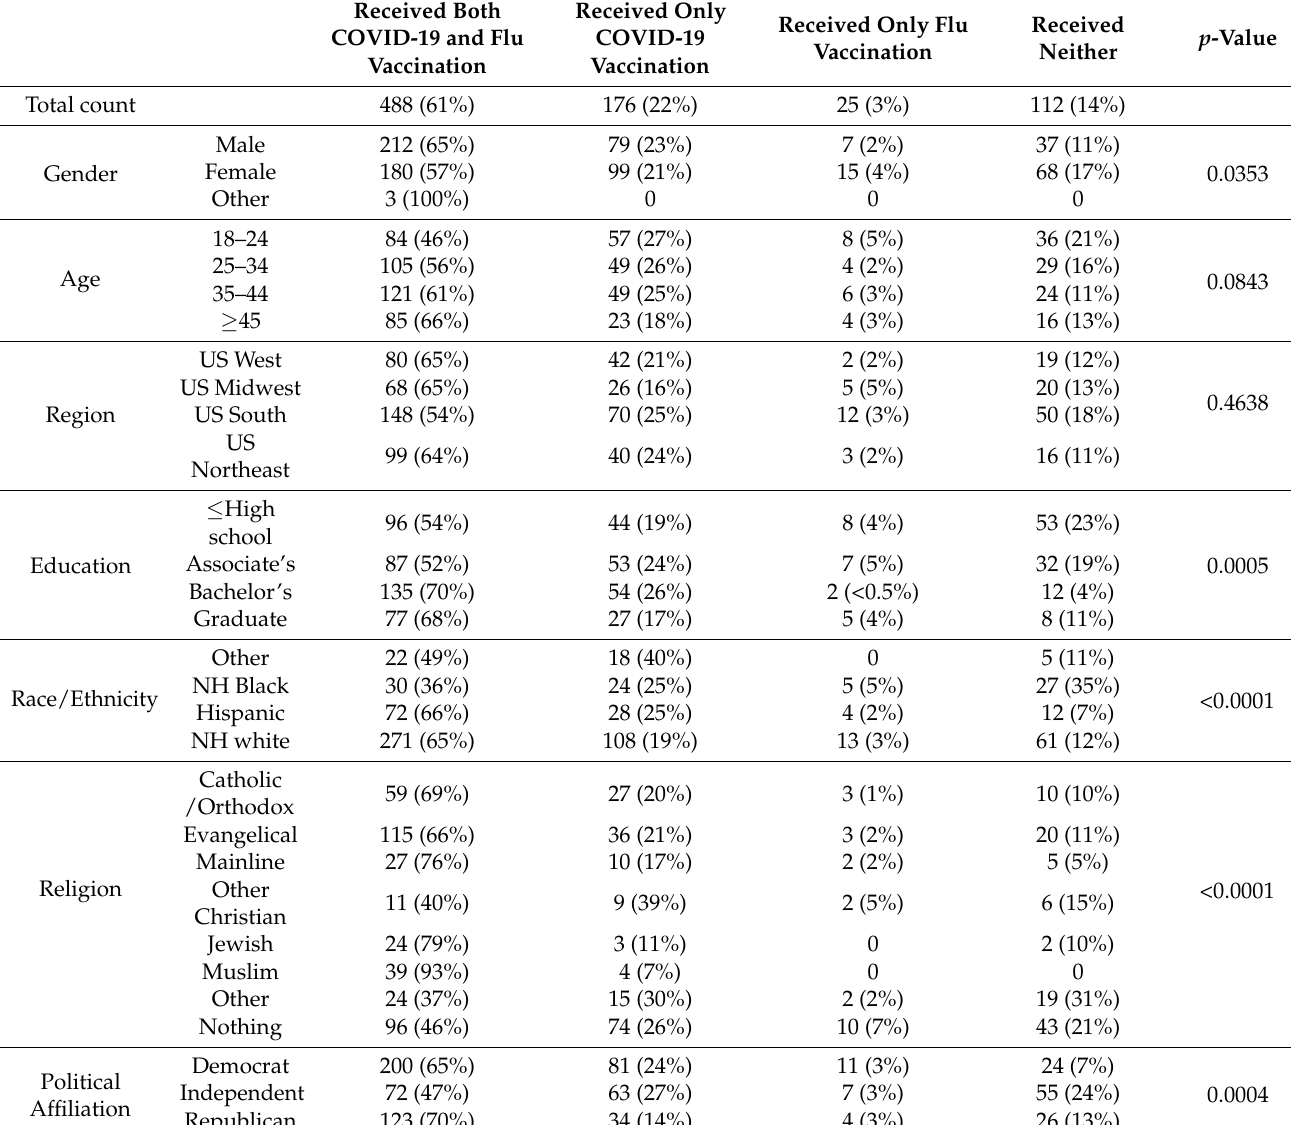
Table 2. The demographic characteristics of the non-receipt of COVID-19 and flu vaccinations; August